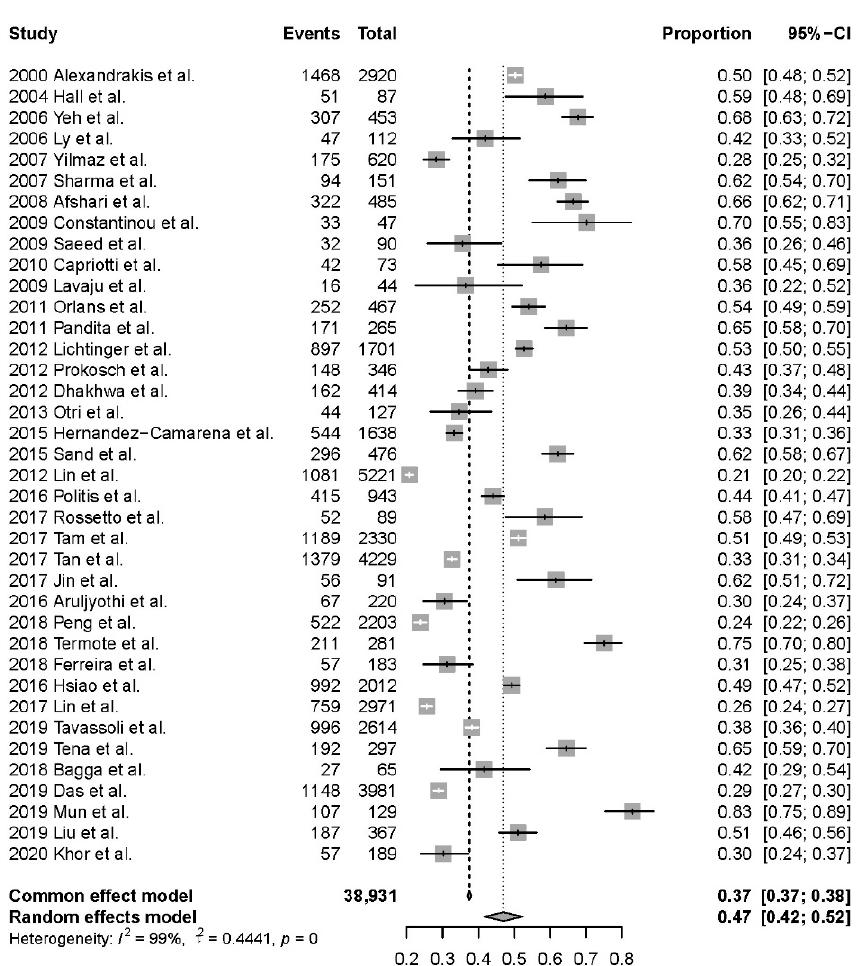
Figure 3. Positive rate of bacterial culture from corneal lesions in different regions. 2.3. Distribution of Bacteria Isolated from Corneal Lesions Within 14,596 samples reported from 38 studies, 15,350 bacterial strains isolated from corneas of BK cases were summarized (Table 2). Gram-positive cocci were the major type